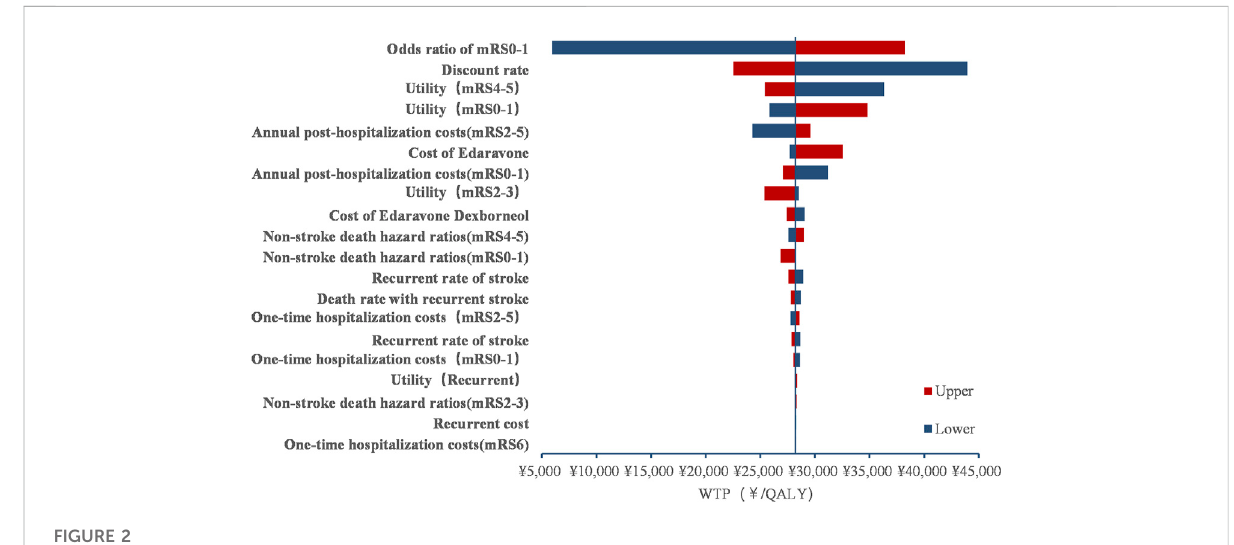
FIGURE 2 Tornado